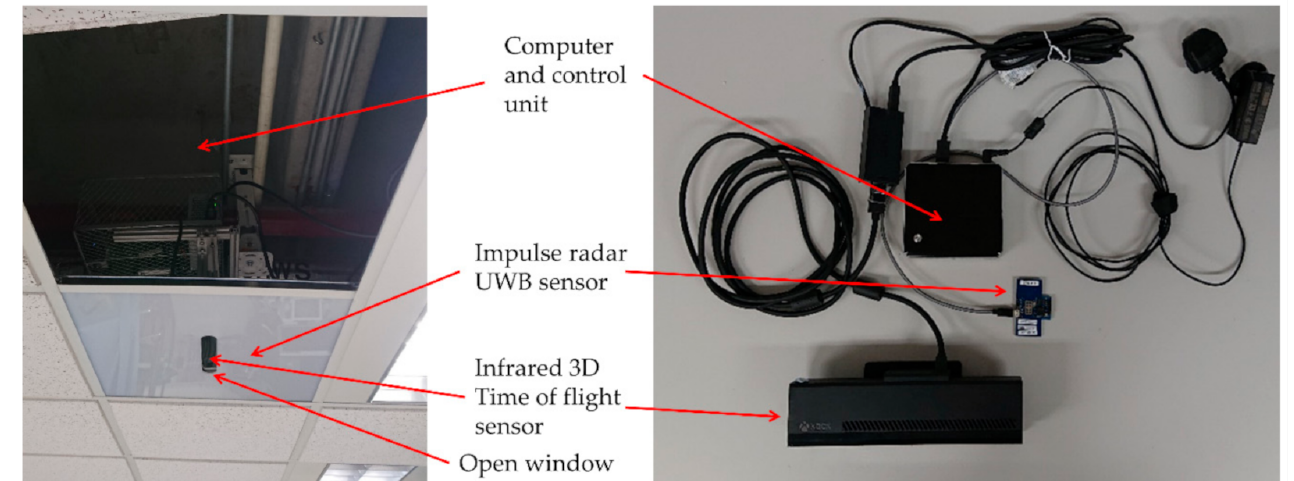
Figure 1. The eNightLog system setup concealed in the suspended ceiling with a windowed plastic